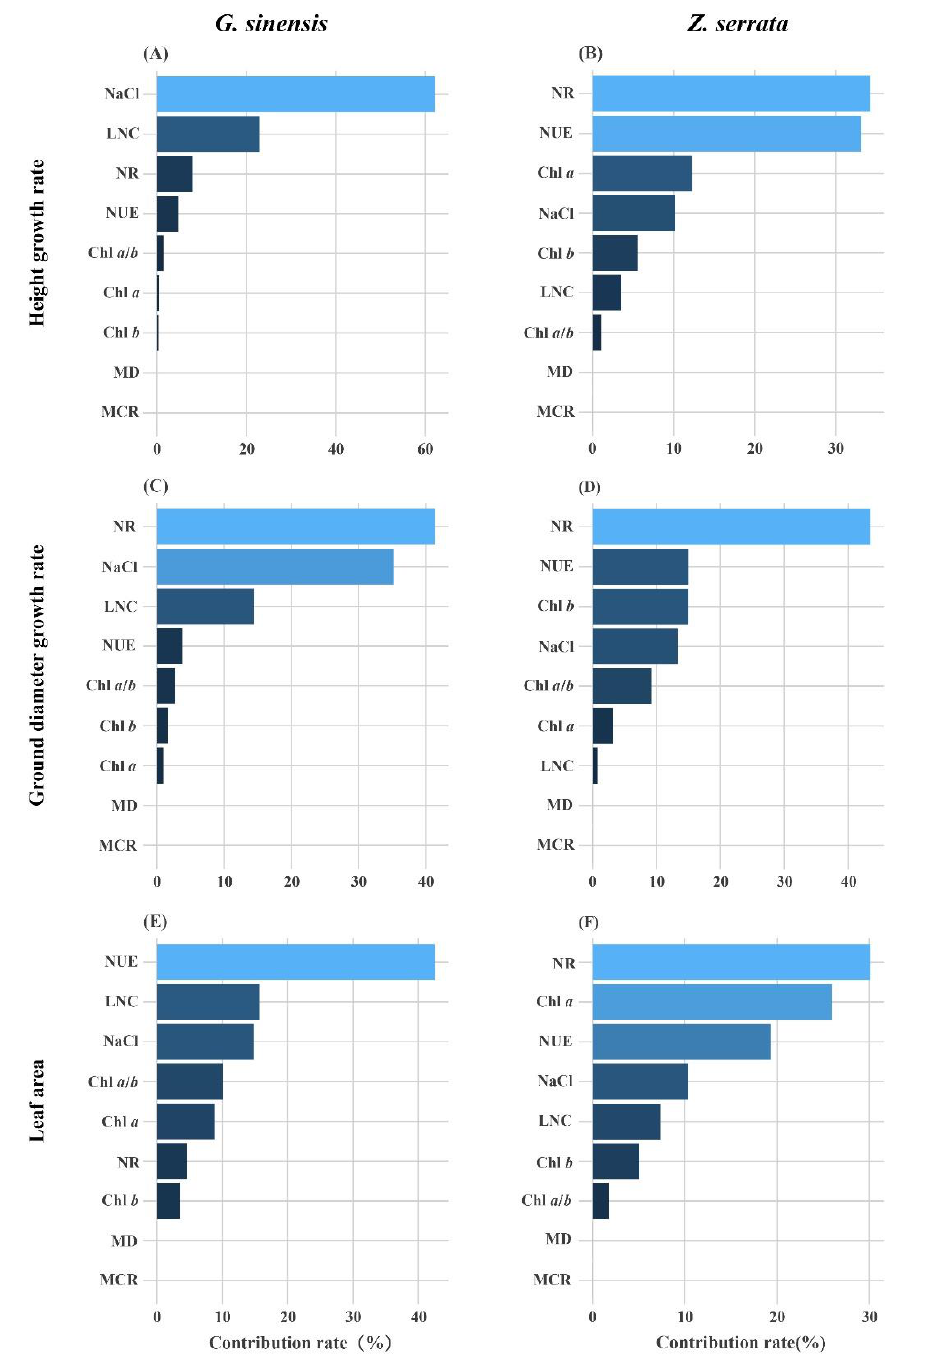
Figure 7. Boosted regression tree model evaluation of the contribution rates of the NaCl level, mycorrhizal colonization rate, mycorrhizal dependency, leaf area, and leaf physiology to plant height, ground diameter growth rate, and leaf area. ( A ) boosted regression tree analysis of G. sinensis height growth rate; ( B ) boosted regression tree analysis of Z. serrata height growth rate; ( C ) boosted regression tree analysis of G. sinensis groud diameter growth rate; ( D ) boosted regression tree